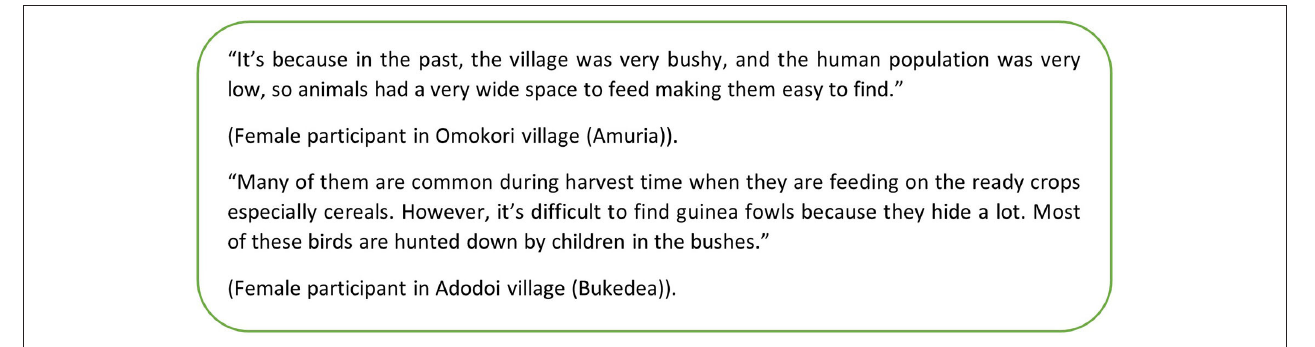
FIGURE 7 | Quotes of female focus group discussion participants about availability in Teso sub-region.